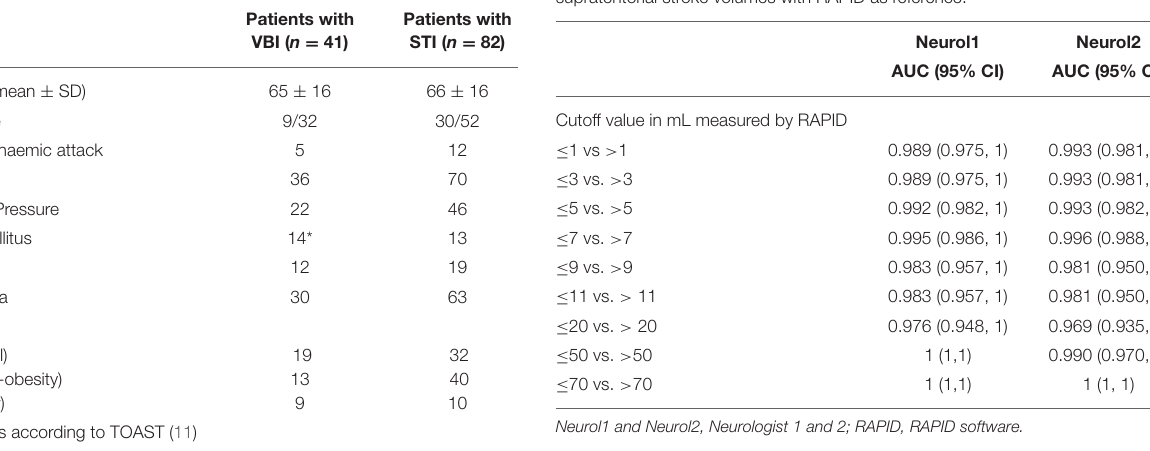
TABLE 1 | Study population characteristics.